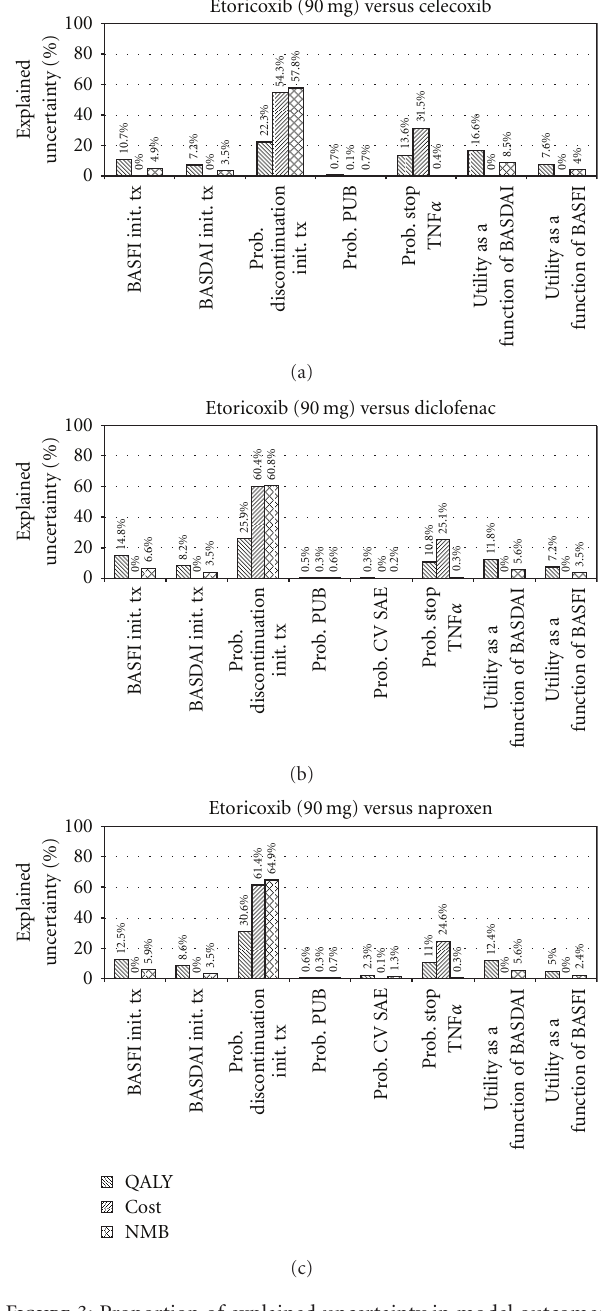
Figure 3: Proportion of explained uncertainty in model outcomes (incremental QALYs, costs, and net-monetary benefit at WTP of 400,000 NOK) by the most relevant variables for the comparison of etoricoxib (90mg) versus celecoxib, diclofenac, and naproxen (base- case